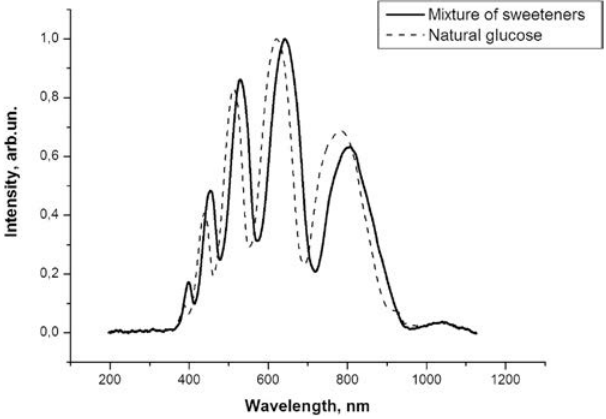
Fig. 4. Transmission spectra of the chirped PCF samples, ¯lled up with aqueous solution of glucose and aqueous solution of cyclamate and saccharin mixture.